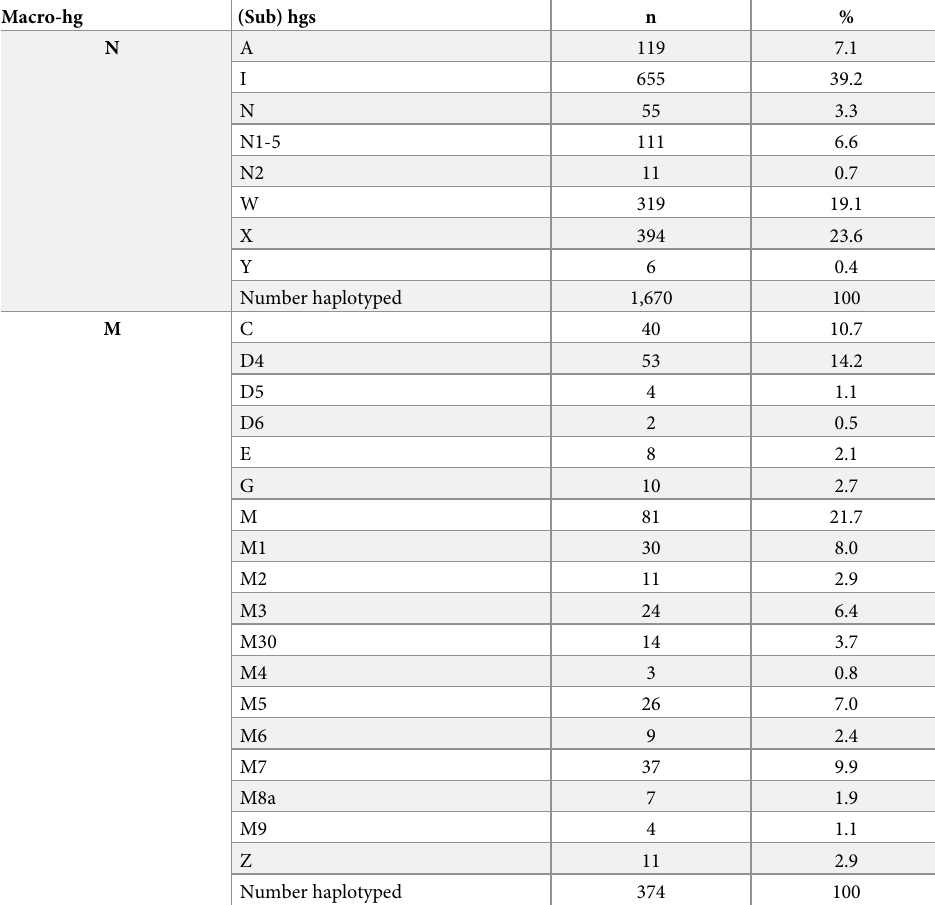
Table 4. Distribution of mtDNA haplogroups contained within the N and M macro hgs.